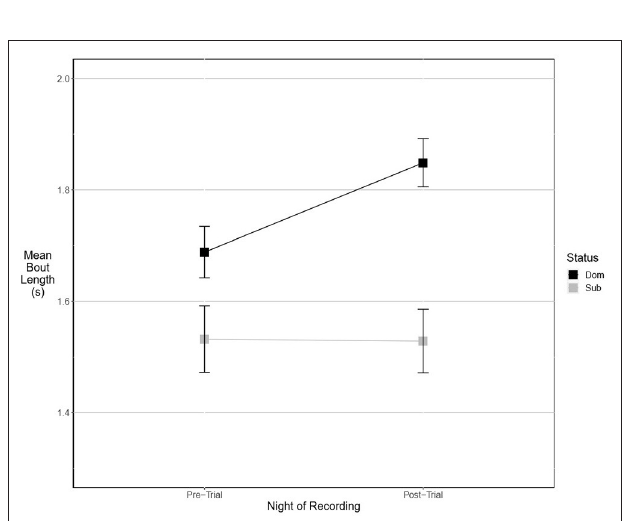
FIGURE 2 | Dominant males signal with longer bouts than subordinate males. This margin is larger after an aggressive interaction. Graph of mean estimates